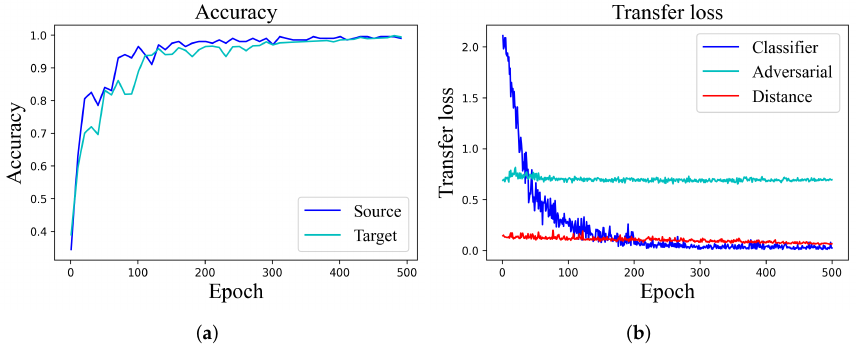
Figure 13. The trend of training accuracy and loss on the MADAN. ( a ) Accuracy. ( b )